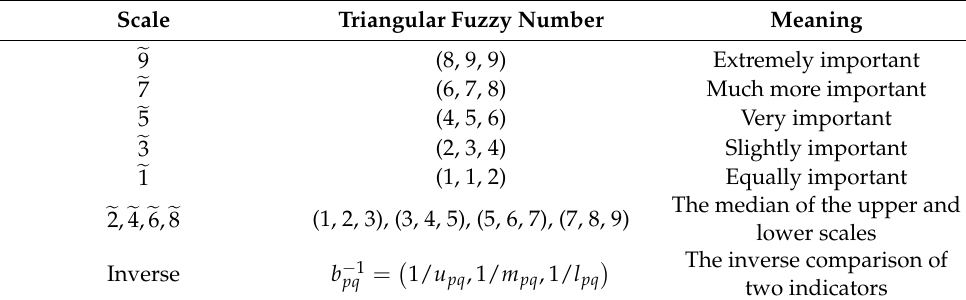
Table 3. The 1–9 scale